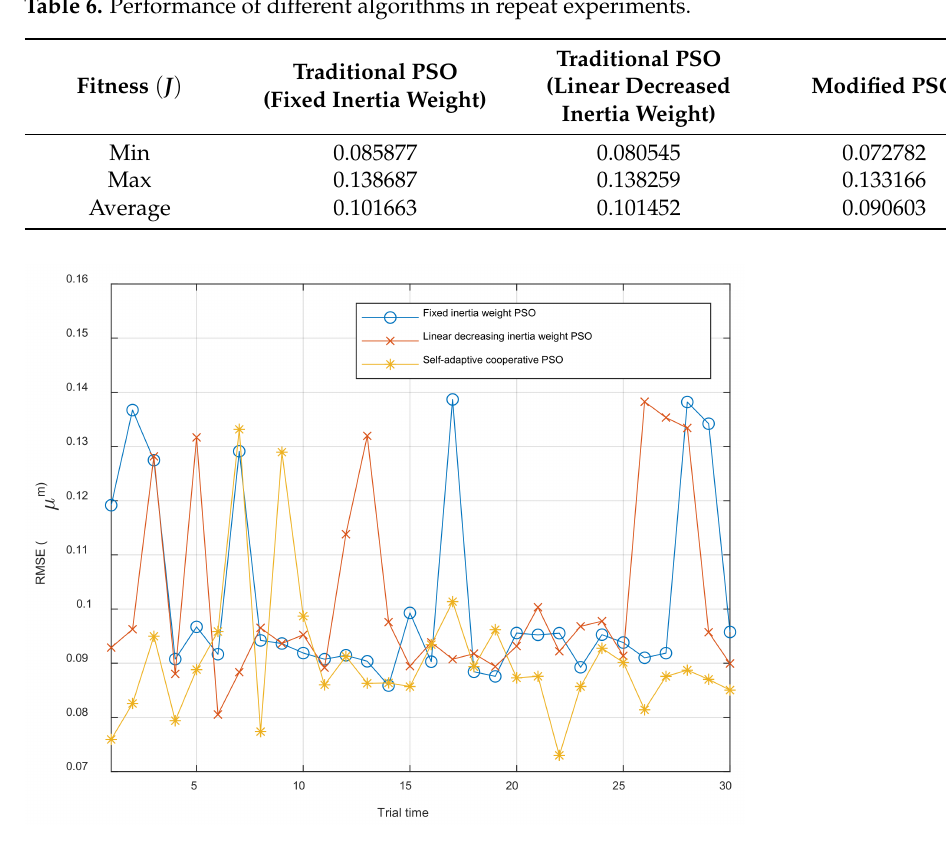
Figure 11. Comparison of 30-times repeat experiments with different